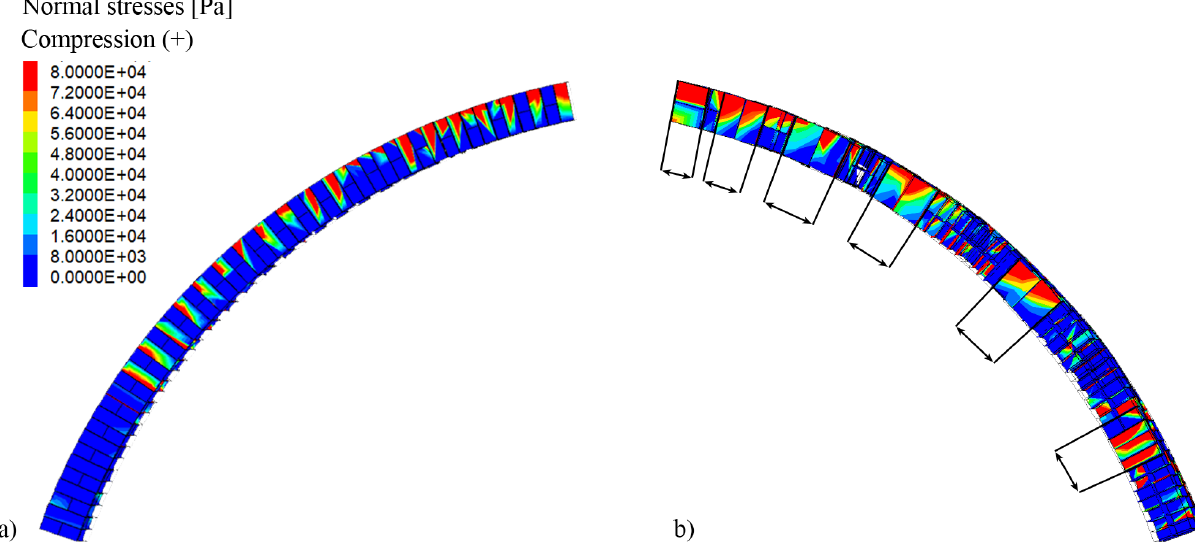
Figure 10: Hoop stresses on vertical joints. a) Common tessellation, the magnitude of stresses increases from the bottom to the crown. b) Cross-herringbone model. The magnitude of stresses increases from bottom to the crown, but in correspondence of rowlock blocks (delimited by black quotes) the normal stress is high regardless of the position of the